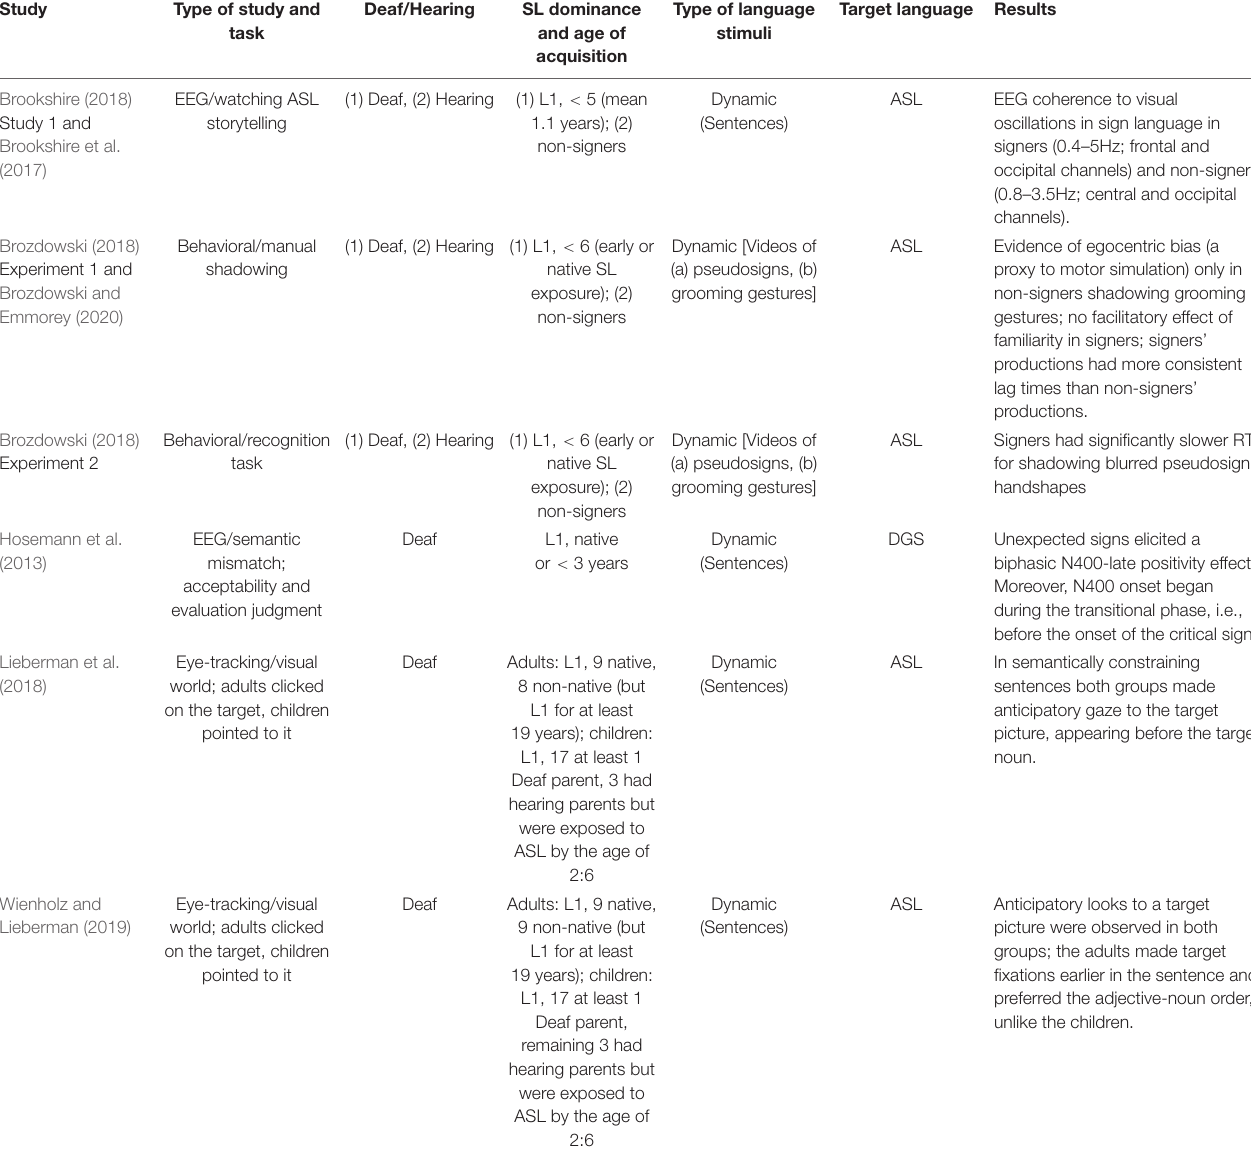
TABLE 1 | Key characteristics of the studies inluded in the final